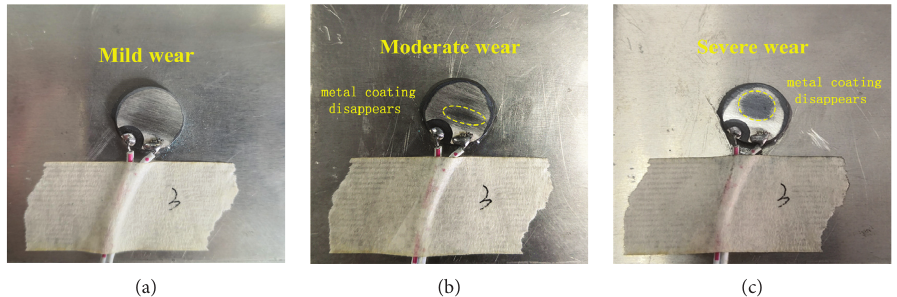
Figure 6: Wear of 3# PZT. (a) Mild wear; (b) moderate wear; (c) severe wear.